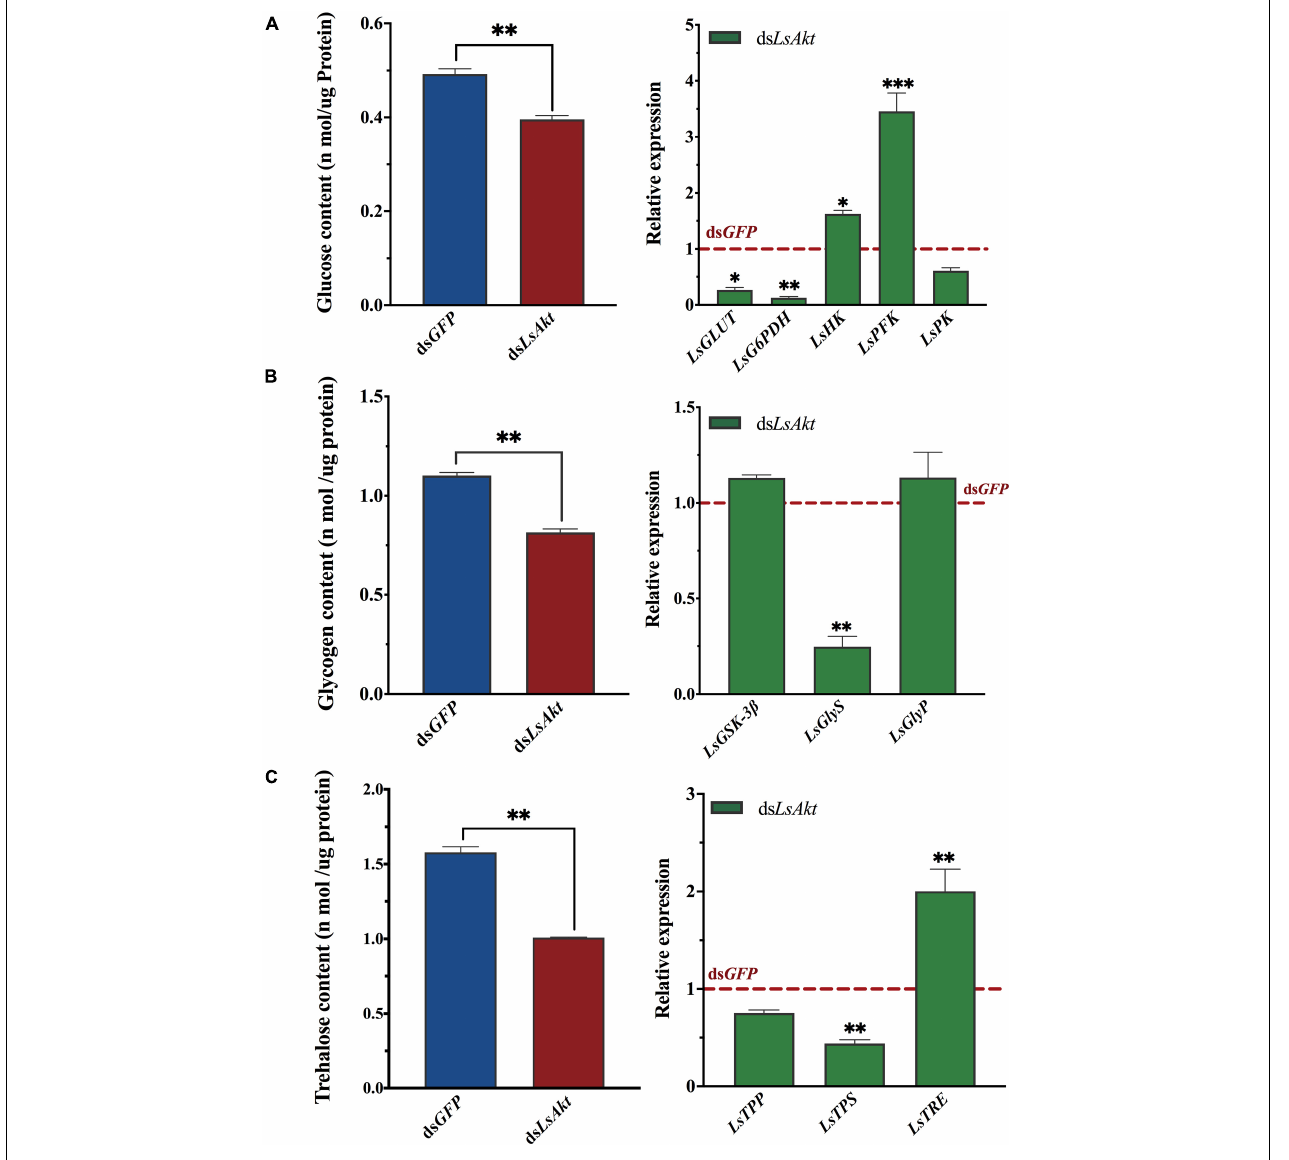
FIGURE 6 | Effect of LsAkt RNAi on carbohydrate metabolism of L. serricorne. (A) Effects of LsAkt knockdown on glucose content and expression of four glucose-related genes. (B) Effects of LsAkt knockdown on glycogen content and expression of glycolytic pathway genes. (C) Effects of LsAkt knockdown on trehalose content and expression of three trehalose metabolic genes. The expression values were calculated by comparison to the ds GFP group, which was normalized at 1. Significant differences between the RNAi group and control group were determined using Student’s t -test ( ∗ P < 0.05, ∗∗ P < 0.01, ∗∗∗ P <